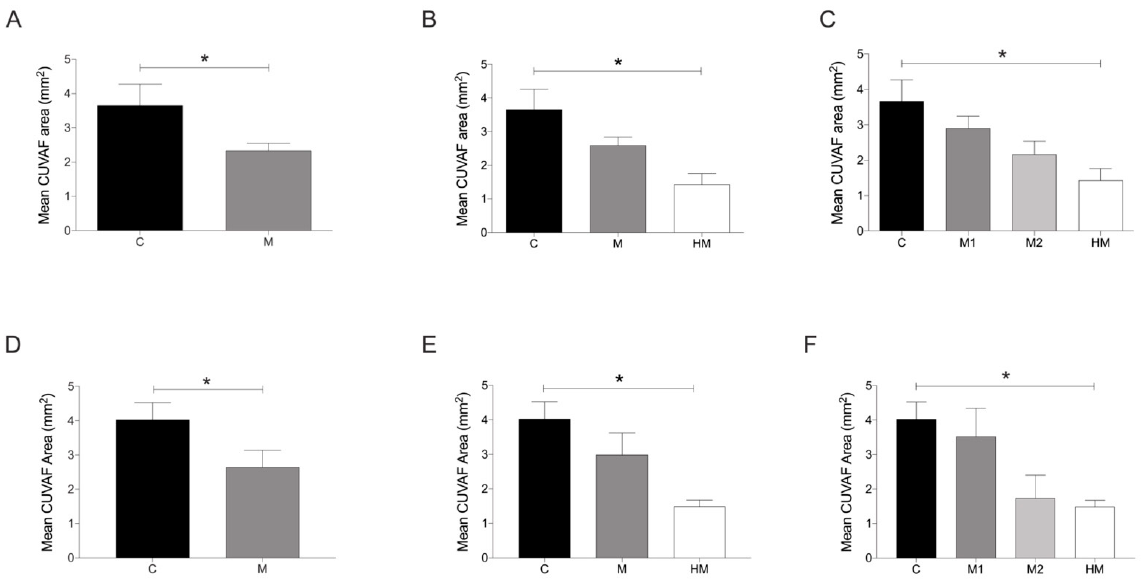
Figure 3. Analysis of differences in mean CUVAF area (mm 2 ) between the control and myopic groups in both student cohorts. ( A ) Medical students: control group vs. myopic group. ( B ) Medical students: control group vs. myopic and HM groups. ( C ). Medical students: control group vs. M1, M2, and HM groups. ( D ) Environmental science students: control group vs. myopic group. ( E ) Environmental